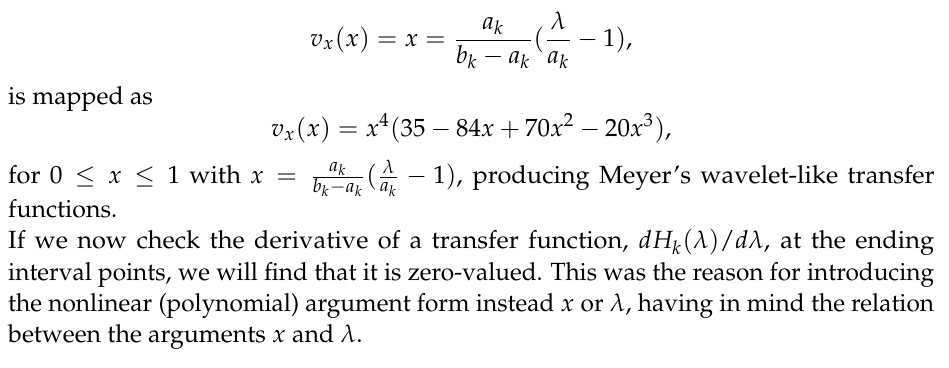
( λ p ) = 1 is H 2 k k = 0